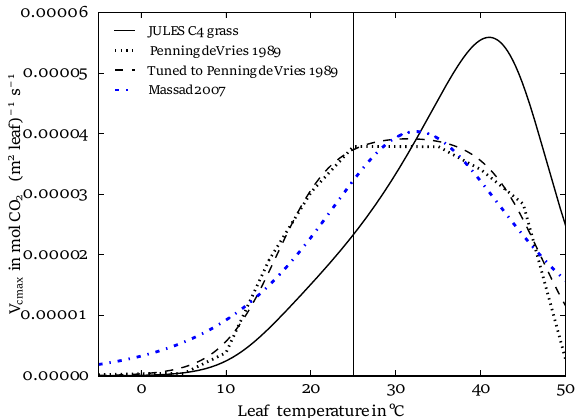
Figure 17. Parametrisations of V cmax against leaf temperature. Solid black line shows default C4 grass in JULES. Dotted line shows the parametrisation for maize given in de Vries et al. (1989), black dashed line shows a fit to this using the JULES parametrisa- tion. Blue dot-dashed line shows the parametrisation for maize in Massad et al.